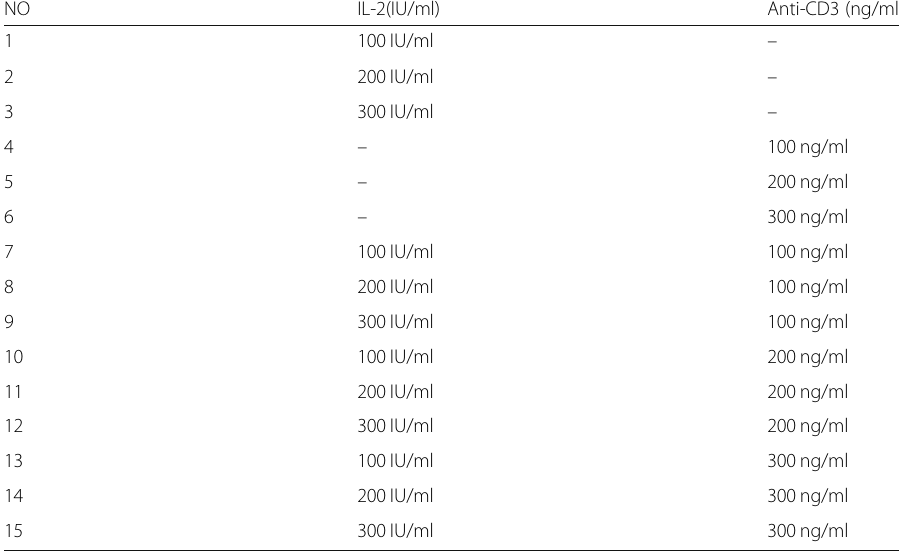
Table 1 Summary of the T cell stimulation methods used NO IL-2(IU/ml) Anti-CD3